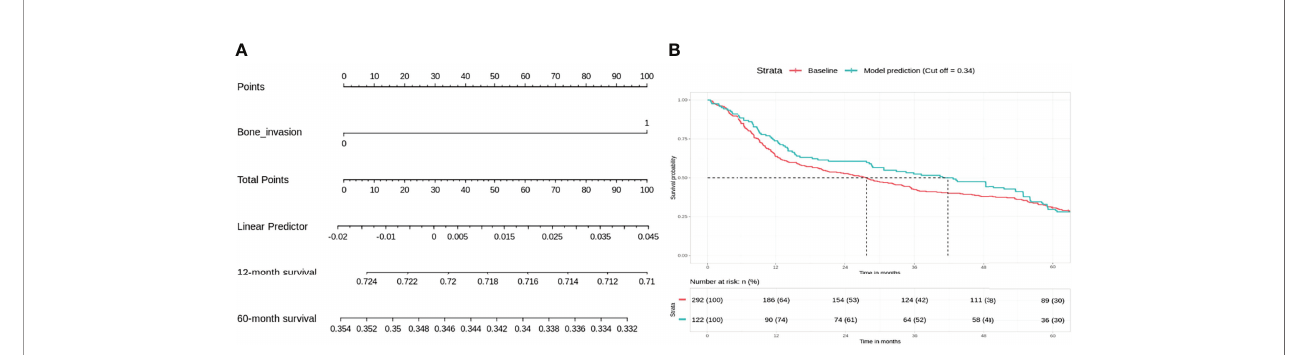
FIGURE 2 | Low risk: nodal stage and perineural invasion (PNI) are negative prognosticators of overall survival. (A) Nomogram model. (B) Internal validation: prediction of 5 ‐ year overall survival with nomogram model as compared to baseline (PR AUC = 0.800). PNI, perineural invasion; PR AUC, precision – recall area under